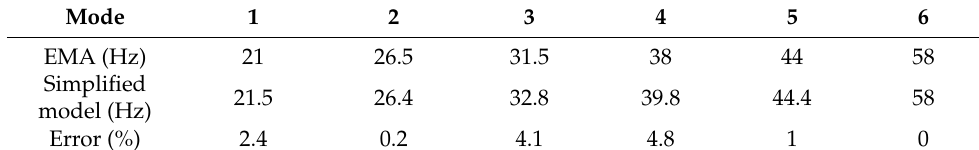
13 of 18 Table 4. Joint stiffness for each part in the movement dimension. Joint